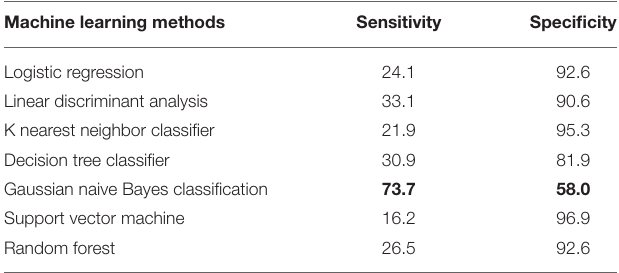
TABLE 2 | Sensitivity and specificity (in %) of machine learning methods for piglet diarrhea detection, from watering, feeding and weight data. Machine learning